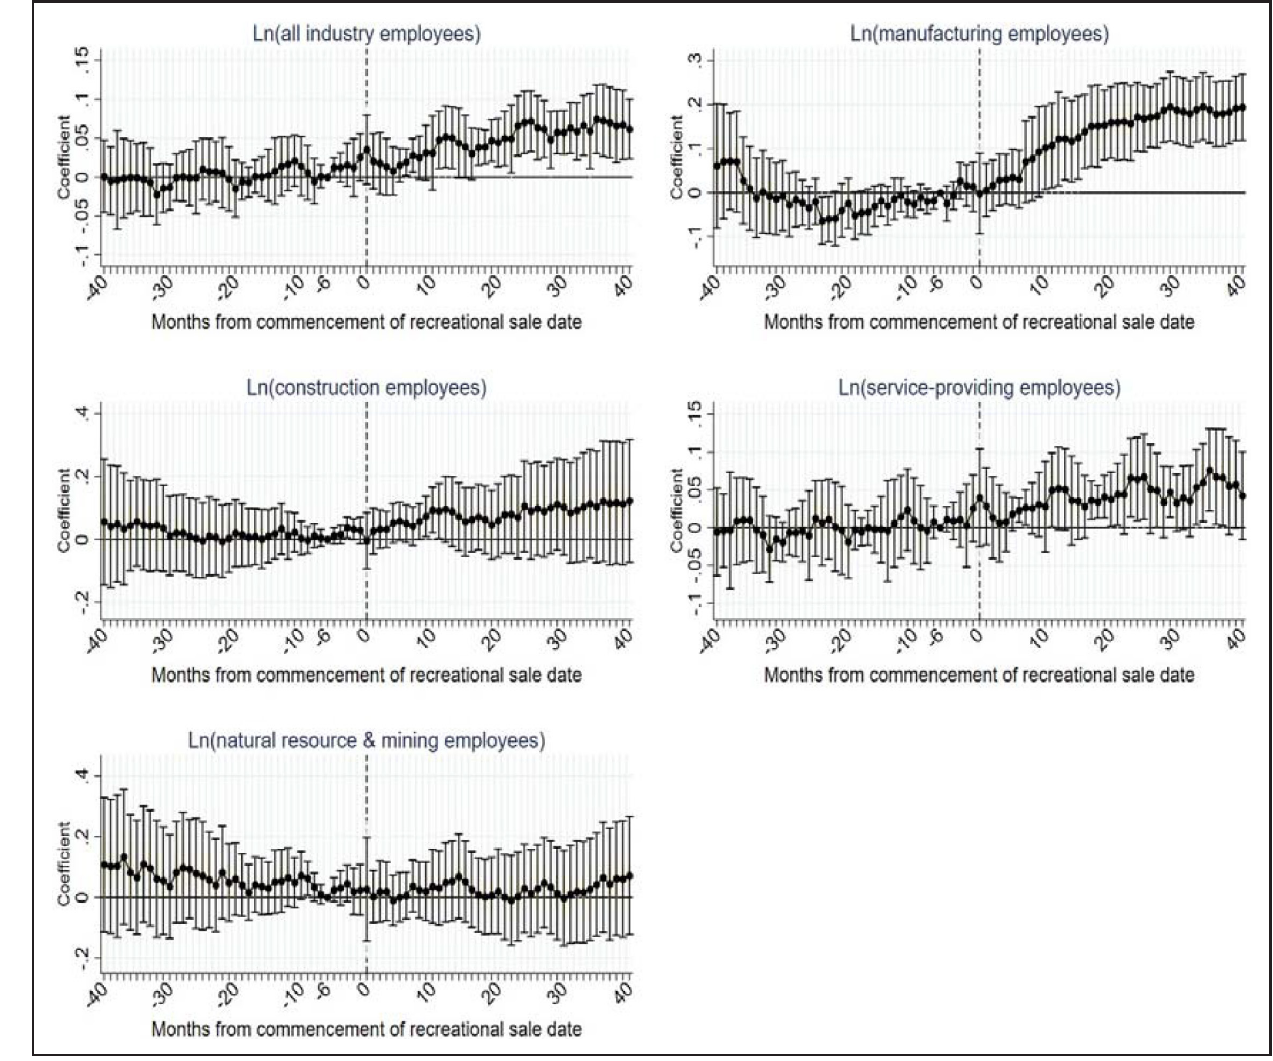
Figure A7 Effect of recreational cannabis entry on Ln(employees) by industry – event